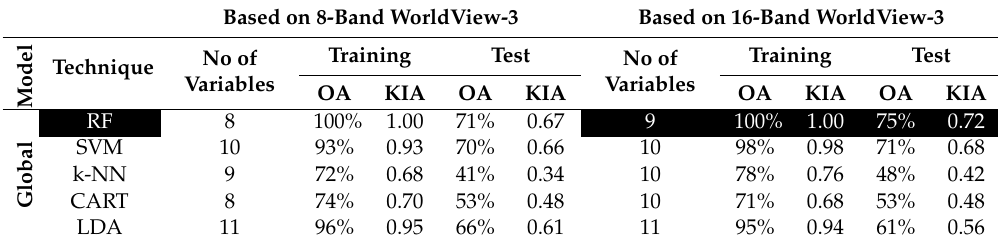
Table 4. Summary of the performance assessment using training and test sets with five modelling techniques (RF, SVM, k-NN, CART and LDA) for global modeling. The modeling technique with the highest overall accuracy (OA) is highlighted in dark. KIA: Kappa index of agreement. Based on 8-Band WorldView-3 Based on 16-Band WorldView-3